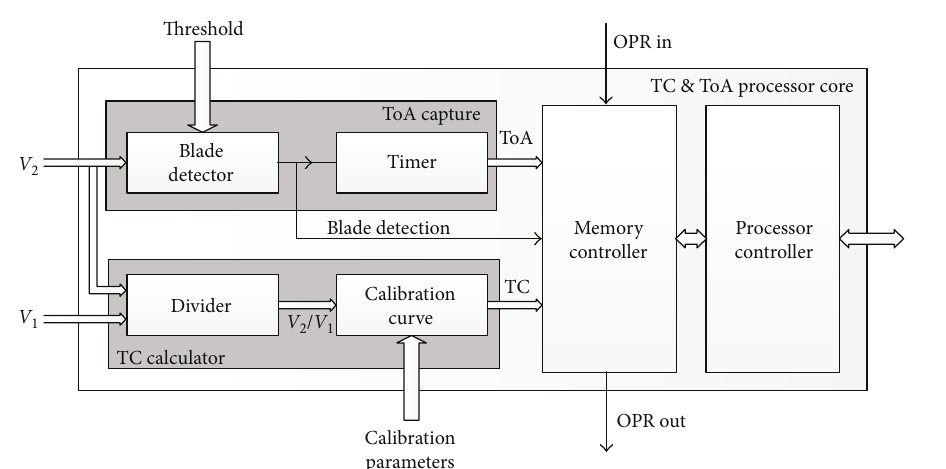
Figure 3: Block diagram of the TC and ToA